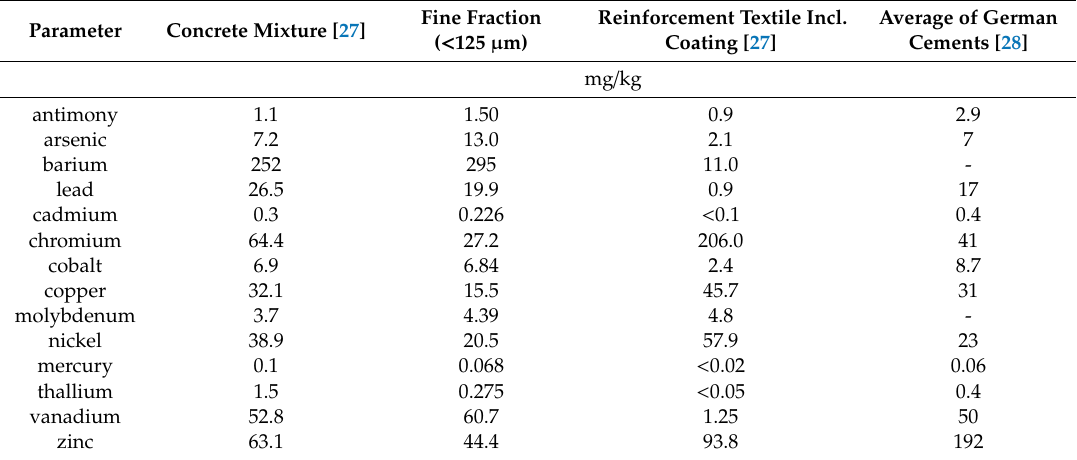
Table 4. Contents of heavy metals and trace elements of the raw